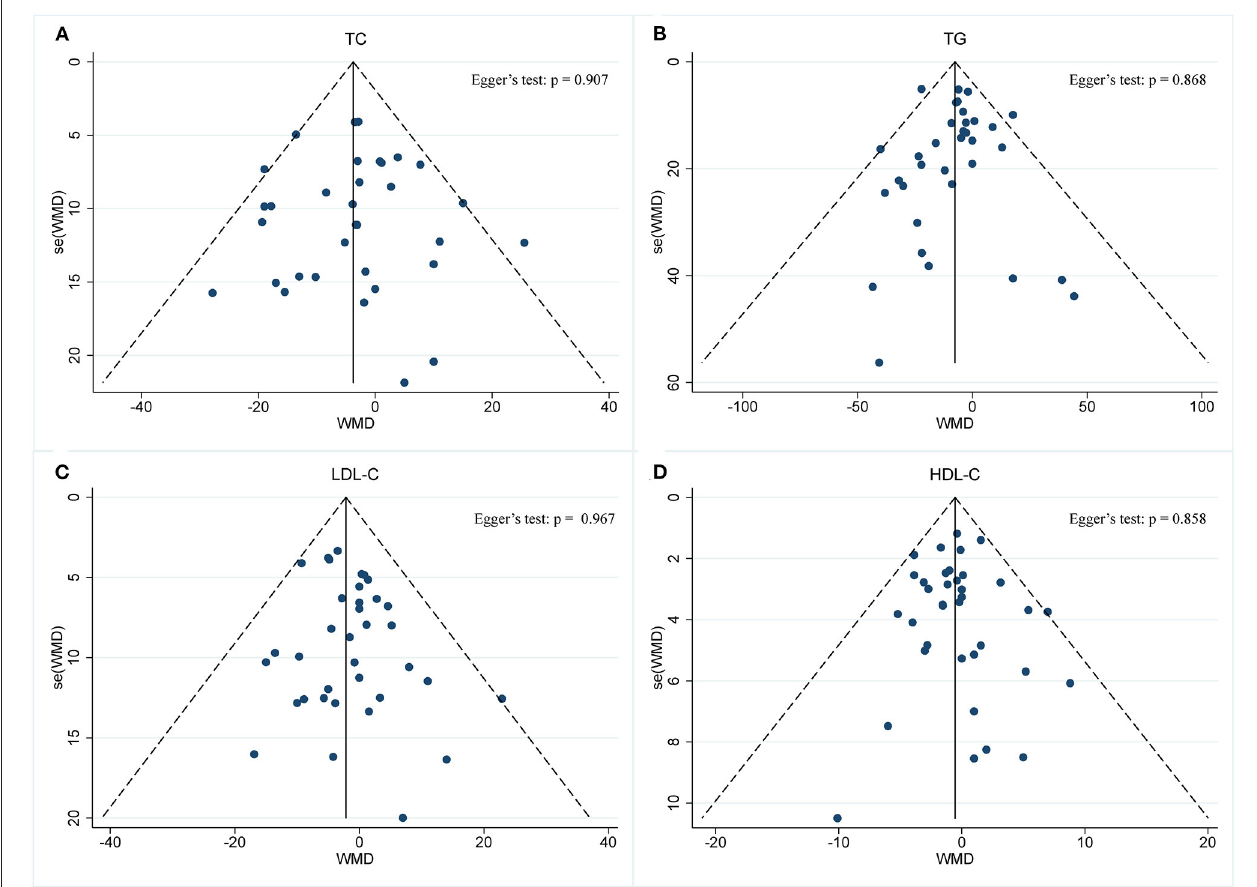
FIGURE 10 | Funnel plot displaying no publication bias in the studies reporting the impact of intermittent fasting on lipid panel (A) TC, (B) TG, (C) LDL-C, (D)